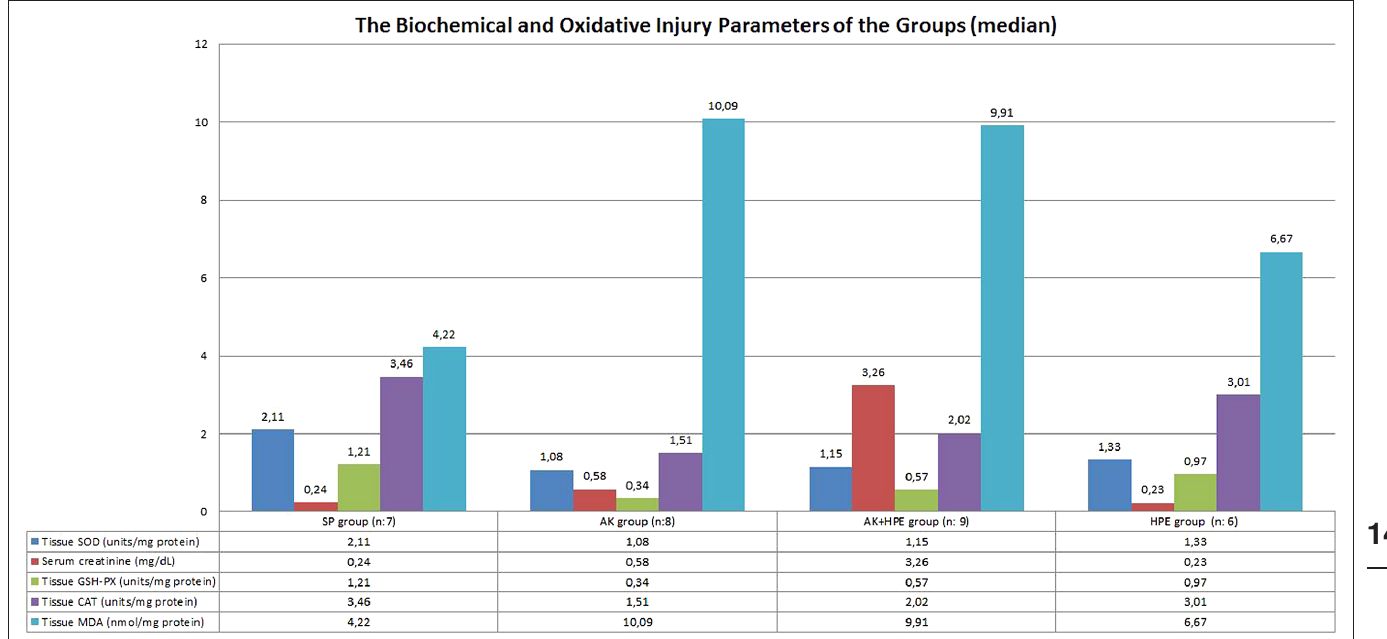
Figure 1. The biochemical and oxidative injury parameters of the groups (median). Oxidative Parameters Kidney MDA levels were lowest in the SP group and highest in AK and AK+HPE groups compared to the others (Table 1 and Figure 1). Malondialdehyde levels of the HPE group were signifi- cantly higher than the SP group and lower than AK and AK+HPE groups. No significant difference was found between SP and